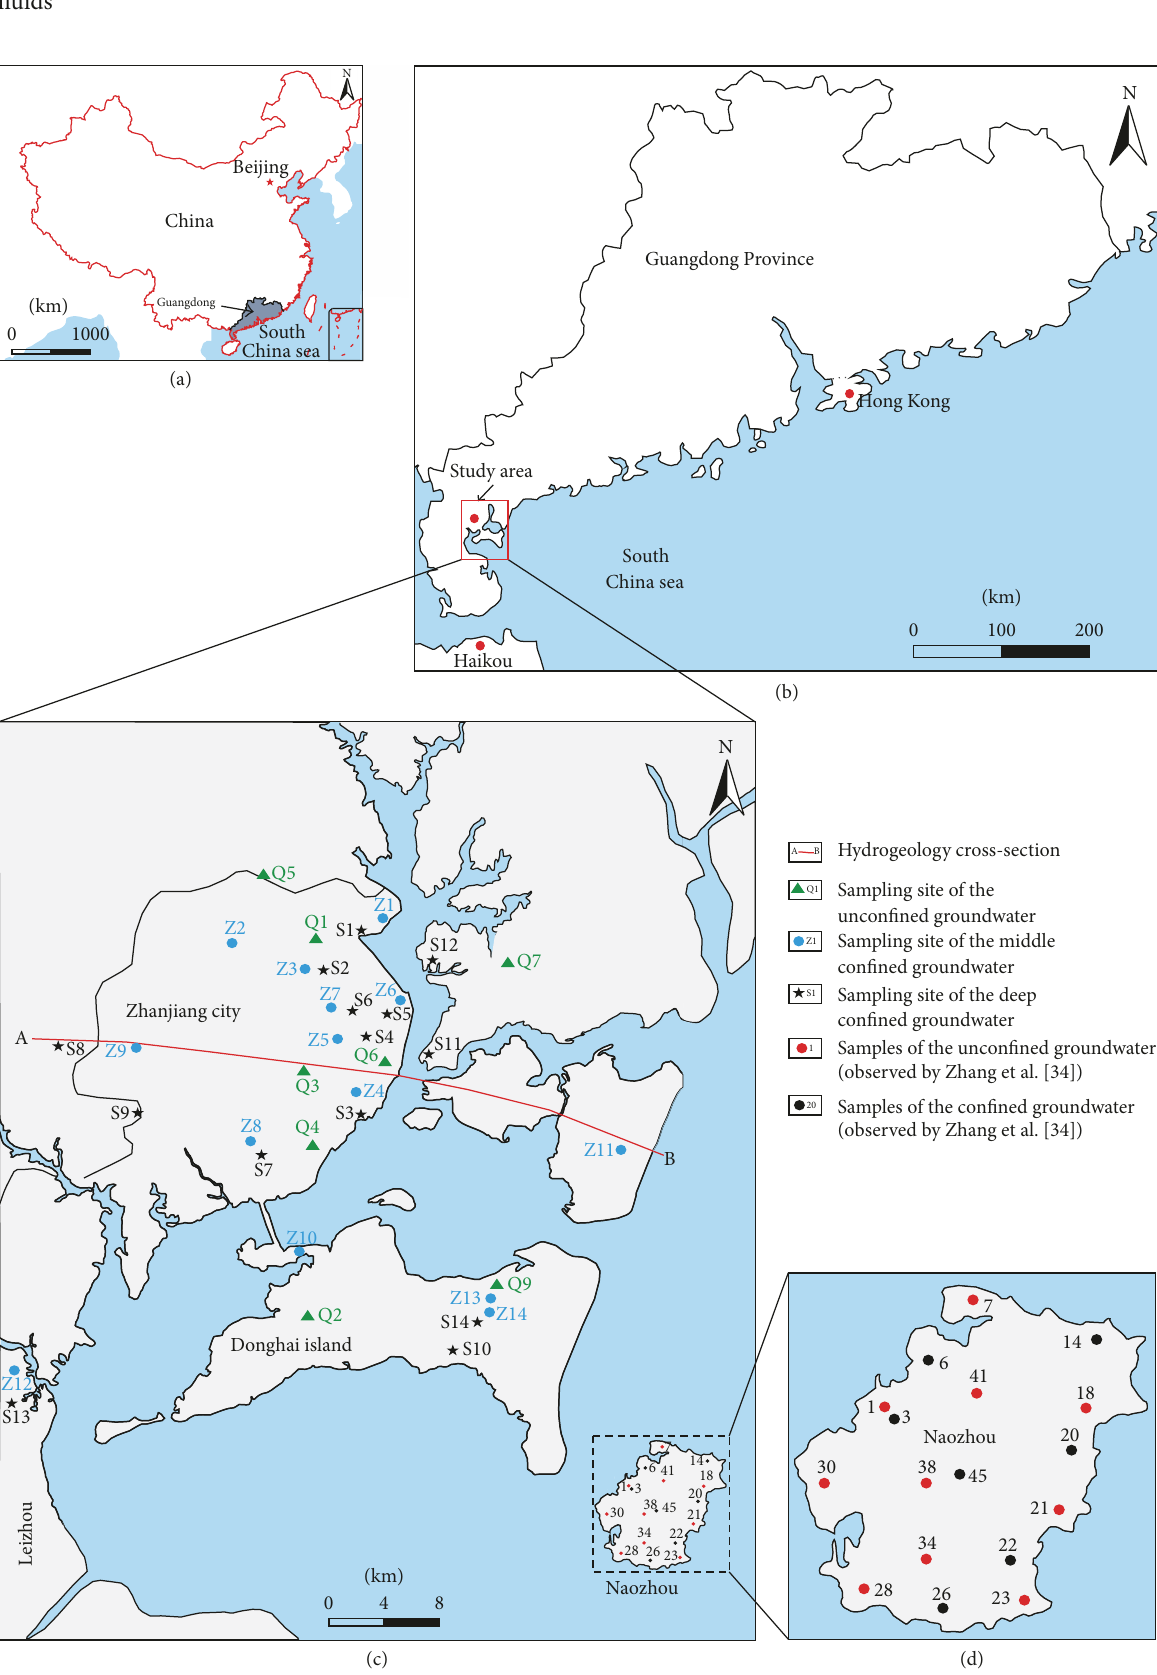
Figure 1: Location map of Zhanjiang (Line A-B illustrates the location of the hydrogeological cross-section displayed in Figure